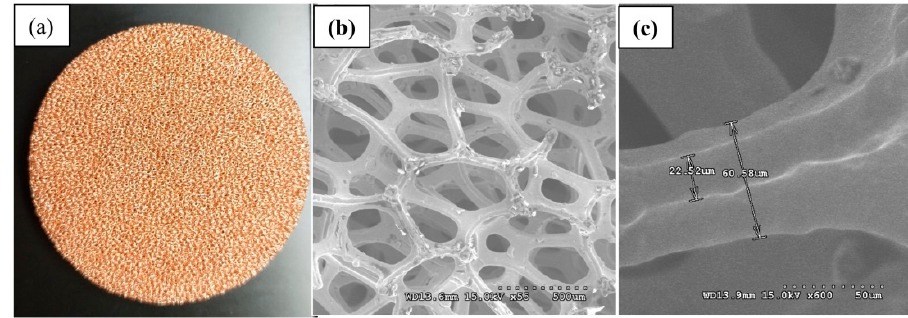
Figure 3. The surface of the OFC specimen: ( a ) Photograph of the OFC specimen; ( b , c ) SEM images of the OFC specimen. Table 1. The measured parameters for OFC test specimens. Sample Number